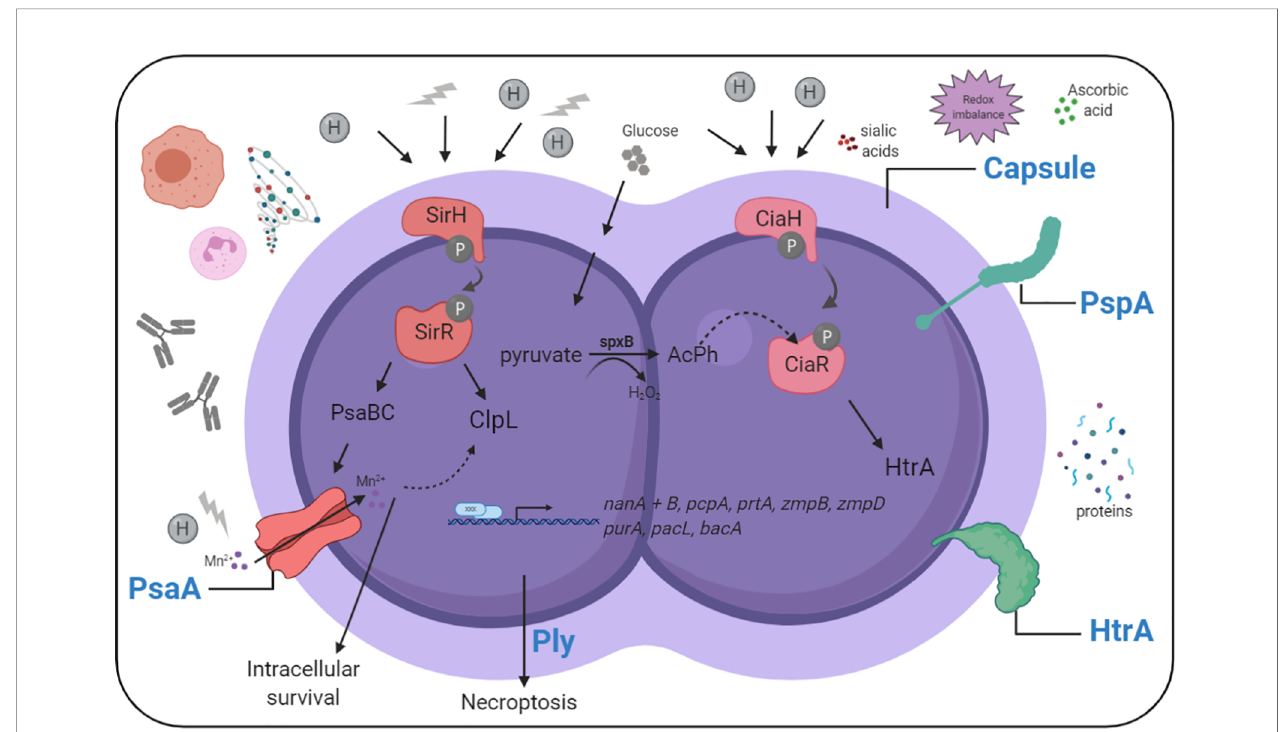
FIGURE 2 | Simpli fi ed overview of pneumococcal sensing and adaptation in the in fl uenza-infected respiratory tract. Pneumococci need to adapt to nutritional and environmental changes in the in fl uenza-infected respiratory tract to cause disease. Sensing and adaptation of pneumococci in the in fl uenza-infected respiratory tract includes activation of two component systems, and the expression of effector proteins helping the bacteria to grow and resist stress in this environment. Created with BioRender.com